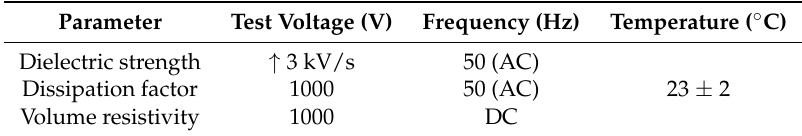
Table 1. Test conditions for electrical measurements.